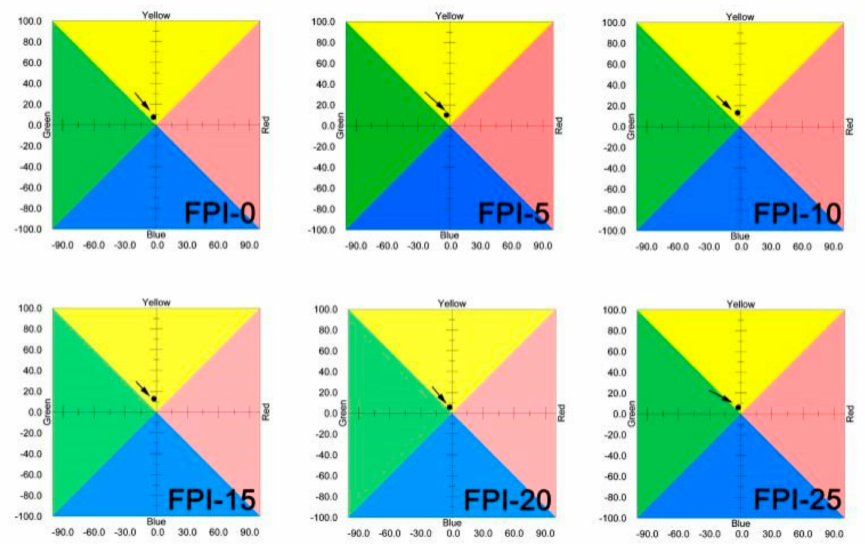
Figure 11. CIE Lab parameters of PI composite